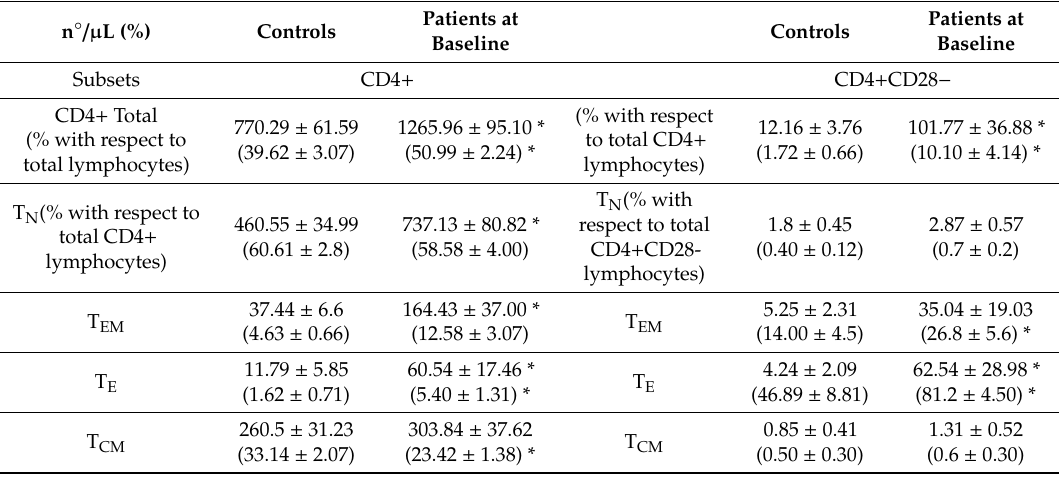
Table 2. Activation / di ff erentiation stage of CD4 T lymphocyte subsets in the recently diagnosed DMARD-naïve patients at